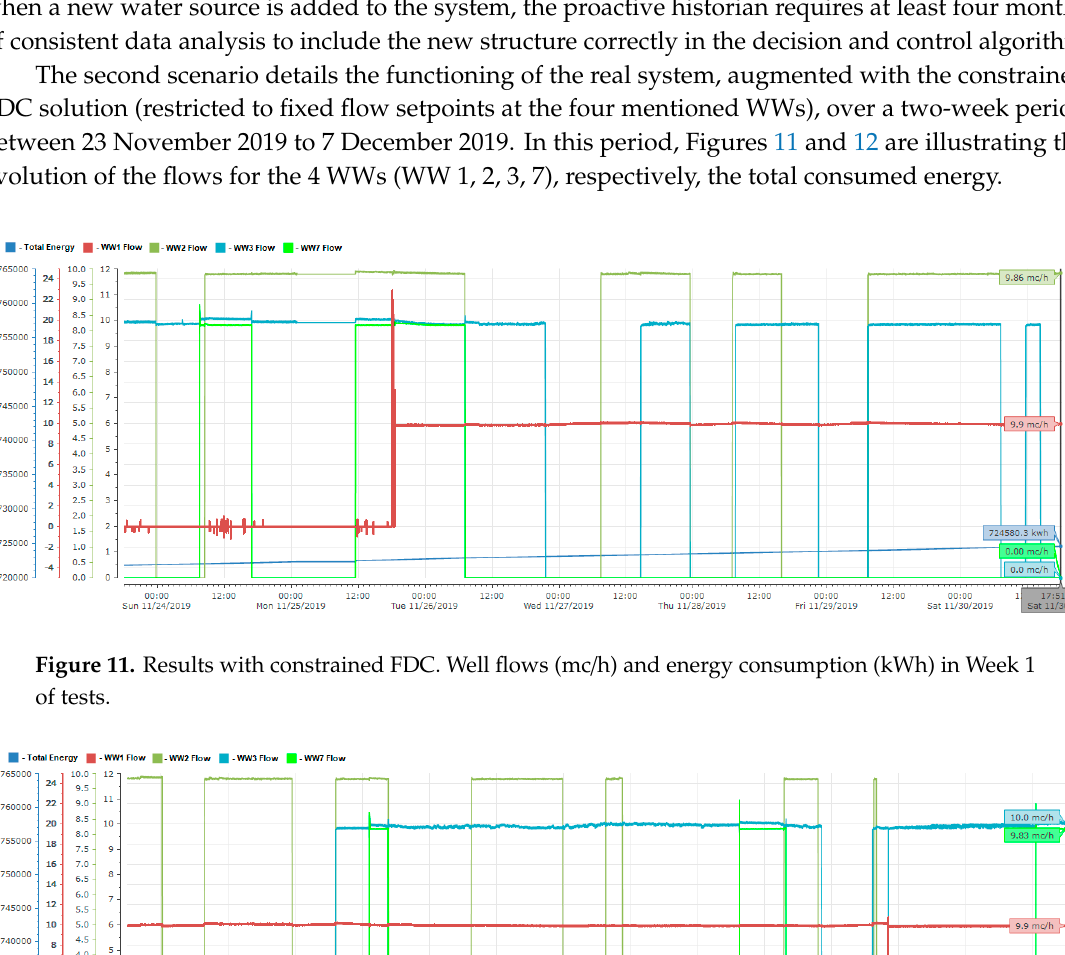
Figure 13. Results without FDC. Well flows (mc/h) and energy consumption (kWh) in Week 1 of tests.